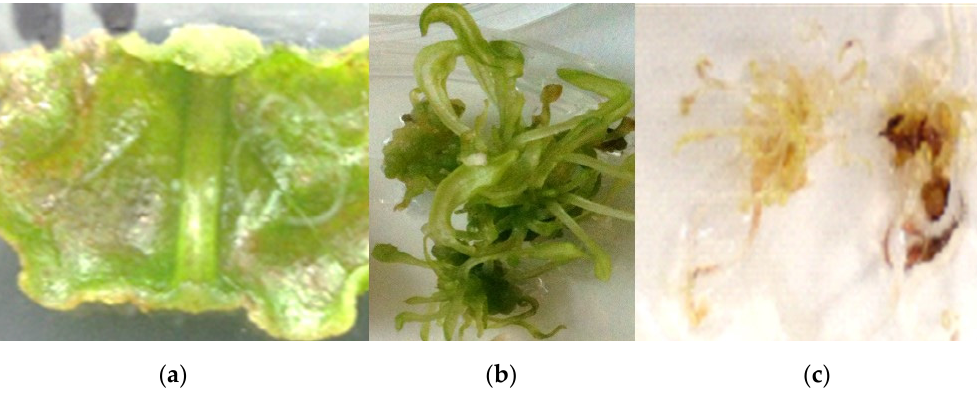
Figure 1. Callus induction from leaves. ( a ) Callus derived from T. officinale leaves under light conditions in the 1st week after induction; ( b ) shoots in callus from leaf explants under light conditions in the 4th week after induction; ( c ) shoots in callus from leaf explants under dark conditions in the 4th week after induction (medium MS supplemented with sucrose 2.3%, 0.1 mg/L of NAA, and 2.0 mg/L of BAP and maintained under light conditions at 18 ± 2 °C).